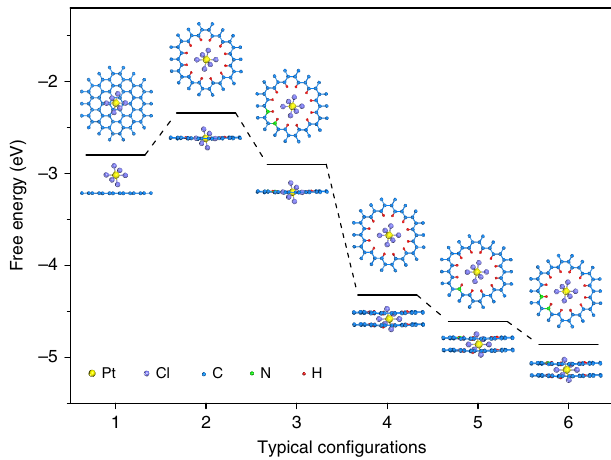
Fig. 2 Six typical con fi gurations of [PtCl 6 ] 2- on different supports and corresponding calculated free energies. 1 Graphene sheet. 2 Graphitic mono-layer with a micropore of 0.6 nm. 3 Graphitic mono-layer with the micropore decorated by two py-N atoms. 4 Graphitic bi-layer with a micropore of 0.6 nm. 5 Graphitic bi-layer with the micropore decorated by one py-N atom. 6 Graphitic bi-layer with the micropore decorated by two py-N atoms